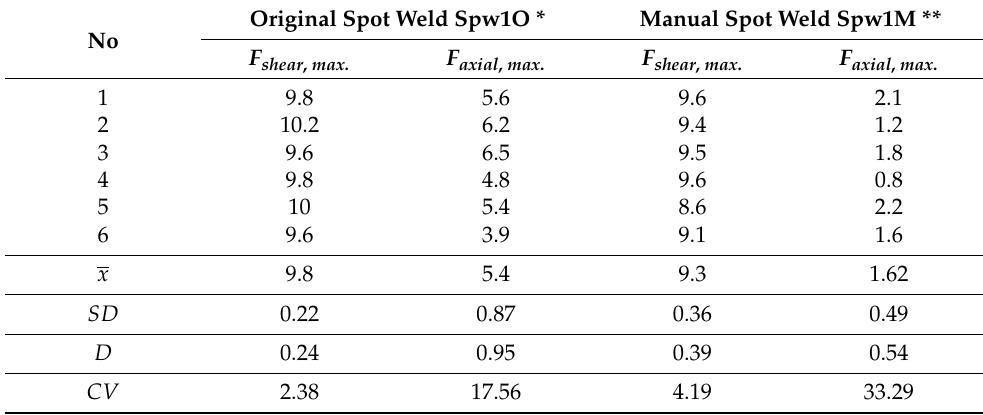
Table A2. Characteristics of the Spw1O and Spw1M spot-welded